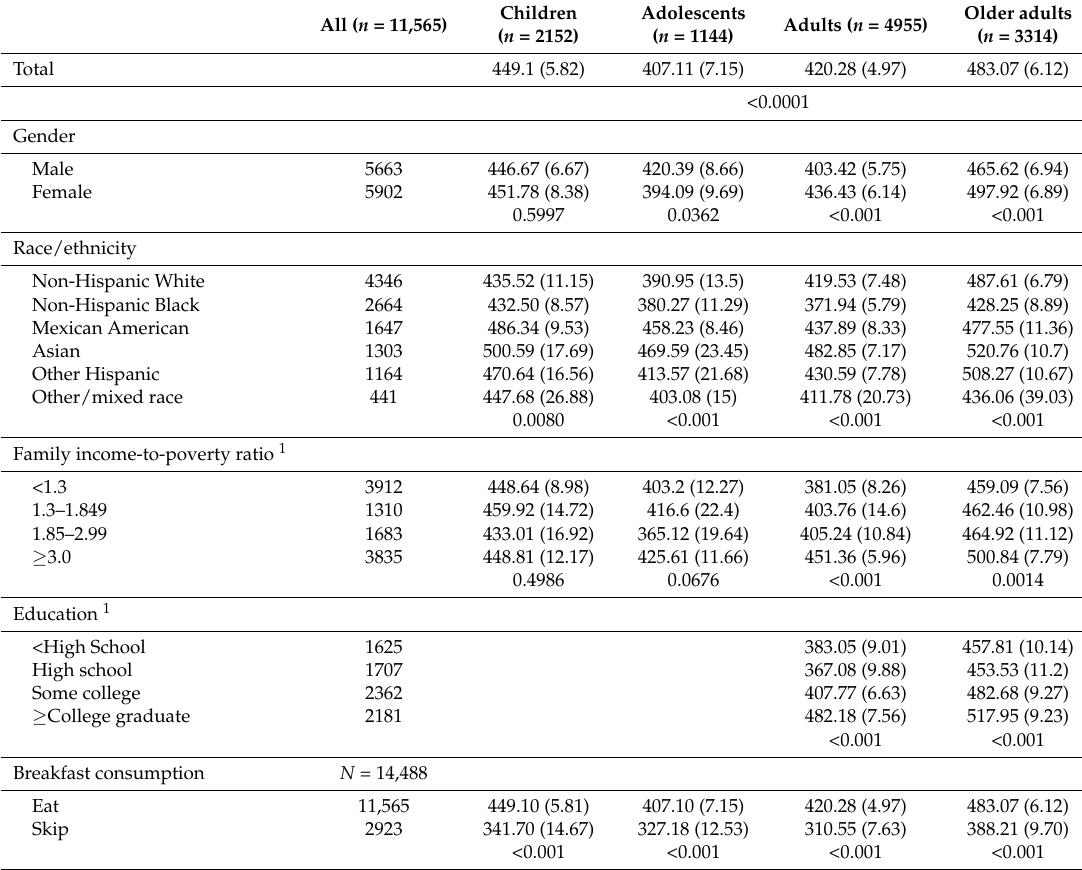
Table 2. Mean ( ± SE) NRF 9.3 scores for breakfast consumers by age and